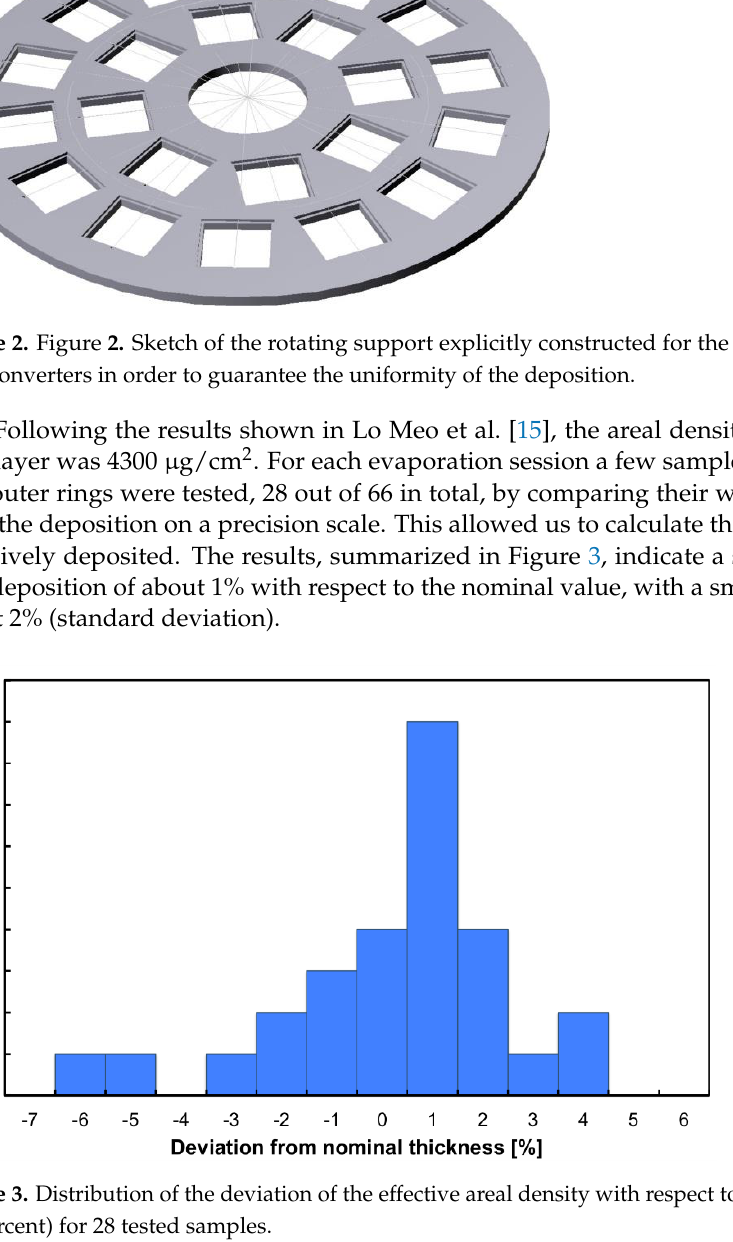
Figure 1. ( a ) The SiLiF detector arrangement as a double sided silicon diode sandwiched between two 6 LiF layers deposited on carbon fiber substrates; ( b ) a real detector assembled inside its alu- minum box.